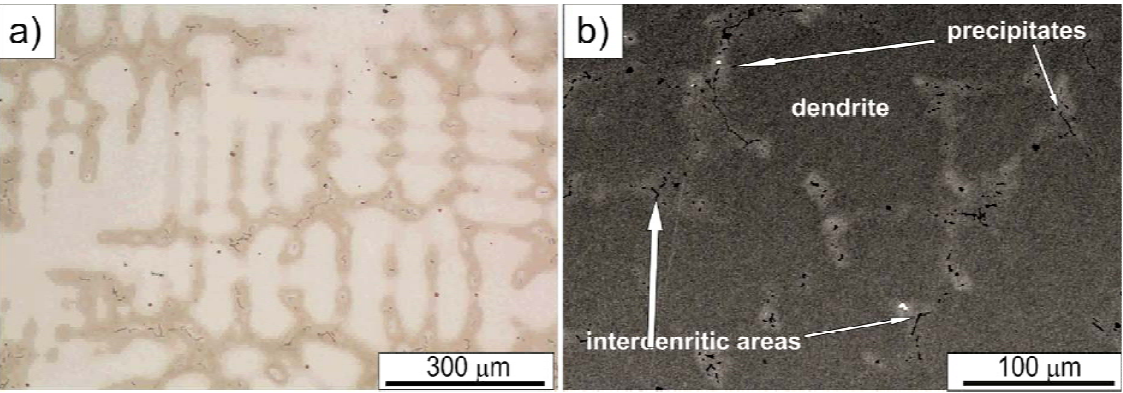
Figure 3. Dendritic microstructure of the as-cast Haynes ® 282 ® : ( a ) Light Microscopy (LM) image; ( b ) Scaning Electron Microscopy in backscattered electrons mode (SEM-BSE) image.